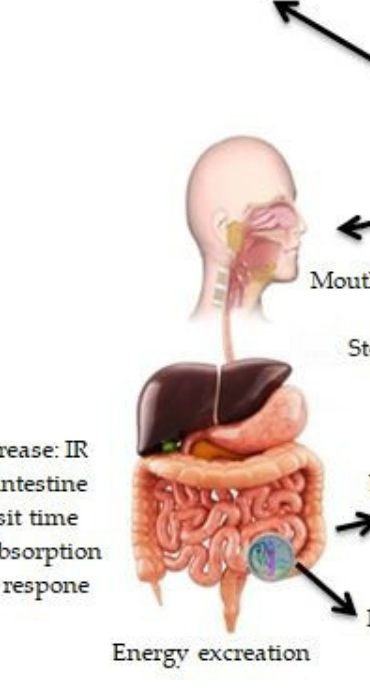
Figure 1. The influence of whole grains on physiologic parameters regulating body weight and composition is mediated by the structural and physicochemical features of whole-grain meals. IR: insulin response; GLP-1: glucagon-like peptide-1; PYY: peptide; SCFA: short-chain fatty acid.